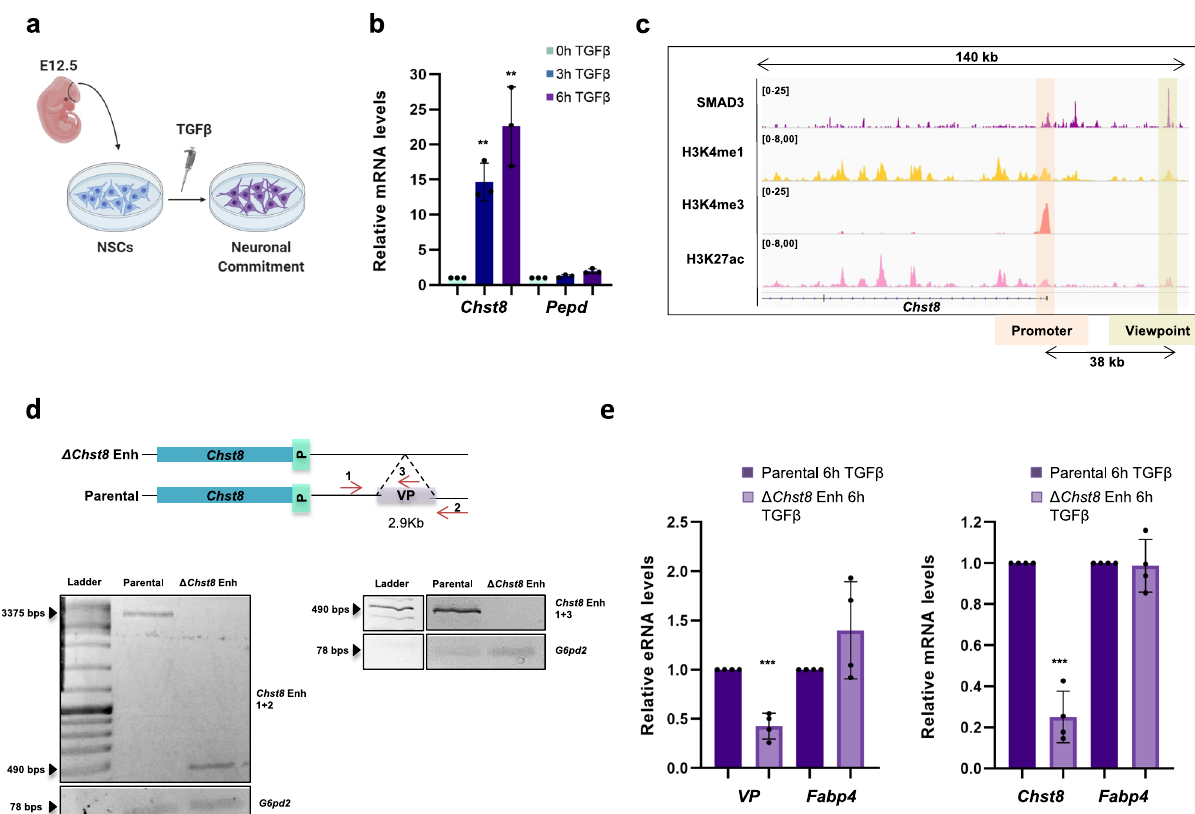
Fig. 1 The VP is an essential Chst8 enhancer. a Schematic view of the model used in this study. NSCs were dissected from cerebral cortices of mouse fetal brains (E12.5) and cultured ex vivo (see methods). TGF β addition leads to neuronal commitment. b NSCs were treated with TGF β . Total RNA was prepared and the levels of the mRNA of the indicated genes were determined by qPCR. Values were normalized to the housekeeping gene Gapdh and the fi gure shows values relative to time 0 h. Results are the mean of three biologically independent experiments. Data are presented as mean values + / − SEM. ** p < 0.01 ( P values were calculated using two-tailed Student ’ s t test, p = 0.001131677 and p = 0.006143072). Source data are provided as a Source Data fi le. c UCSC captures showing the chromatin landscape and SMAD3 binding around the Chst8 gene promoter and the Chst8 putative enhancer (VP) in NSCs. Tracks display ChIP-seq in NSCs treated with TGF β (SMAD3) or untreated NSCs (H3K4me1, H3K27ac, and H3K4me3). Promoter and VP enhancer are shaded in light orange and yellow respectively. d Schematic representation of the CRISPR/Cas9 experimental approach used to delete the Chst8 putative enhancer in NSCs. Two gRNAs fl anking the Chst8 enhancer region were used to create the deletion (2.9 kb). Red arrows represent primers to test the deletion. PCRs using Chst8 deletion and G6pd2 pairs of primers are shown at the bottom of the fi gure in parental and Δ Chst8 enh NSC lines. Results are representative of three independent experiments. Source data are provided as a Source Data fi le. e Parental and Δ Chst8 enh cell lines were treated with TGF β for 6 h. Total RNA was prepared and the levels of eRNA of the VP enhancer (left) or Chst8 mRNA (right) were determined by qPCR. mRNA and eRNA levels of Fapb4 were used as a control. Values were normalized to the Gapdh gene, and fi gure shows values relative to parental line. Data are presented as mean values + / − SEM. Results are representative of three biological independent experiments. *** p < 0.001 ( P values were calculated using two-tailed Student ’ s t test, p = 2.2027E-05 and p = 1.71676E-08). Source data are provided as a Source Data fi